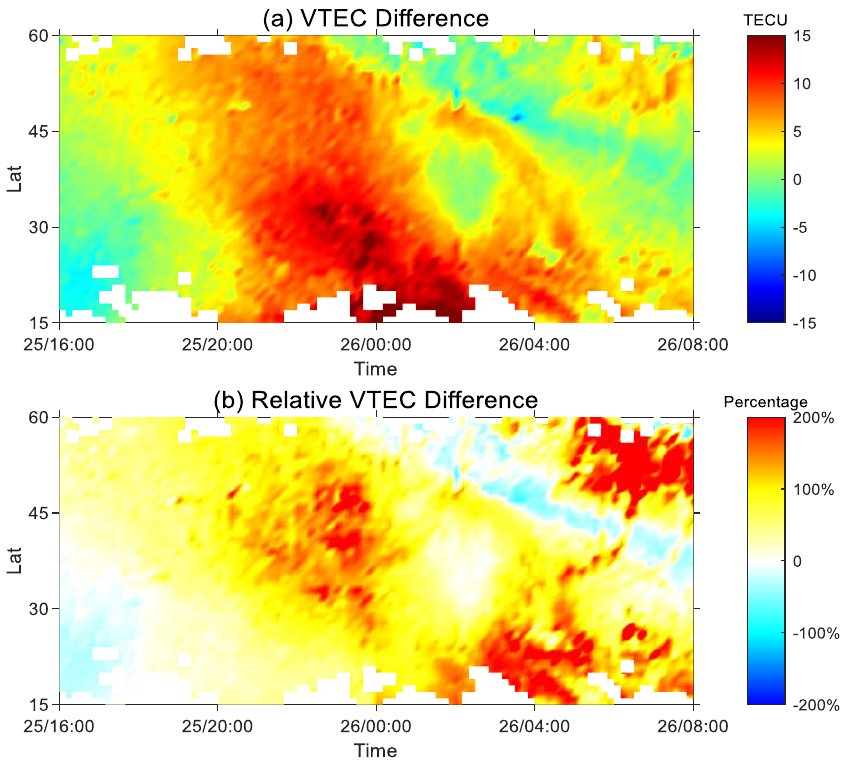
Figure 4. Latitude/time variation of ( a ) VTEC difference and ( b ) relative VTEC difference of the Storm-1 from 15° N to 60° N at 110° W.